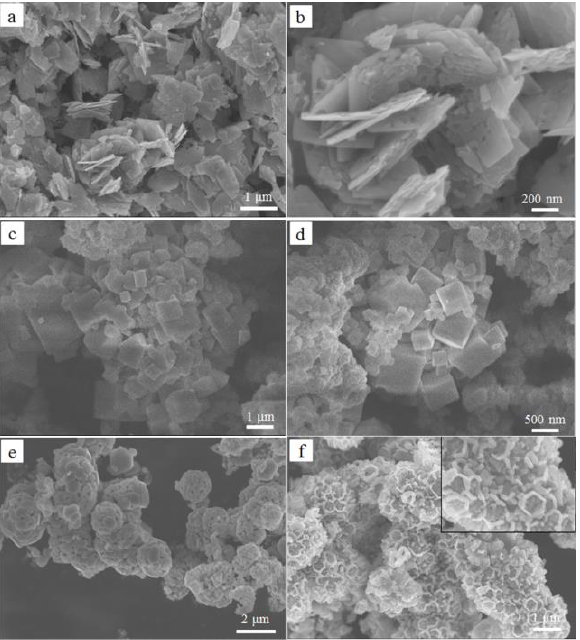
Figure 2. SEM image of samples prepared under different reaction conditions: ( a , b ) S2; ( c , d ) S3; ( e , f ) S5.